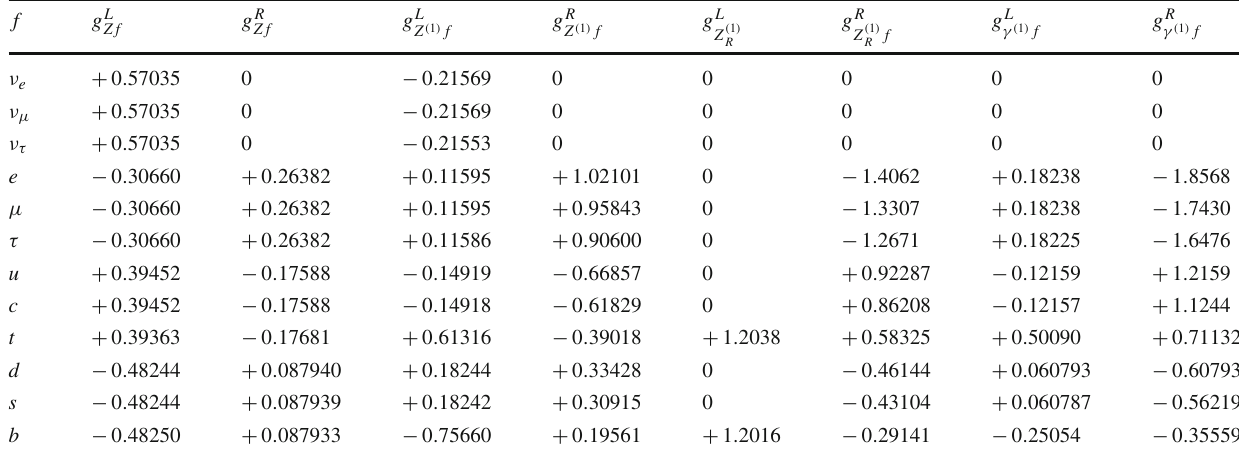
Table 4 Z (cid:3) couplings of fermions for θ H = 0 . 09, c l , c q > 0. The same unit as in Table 3